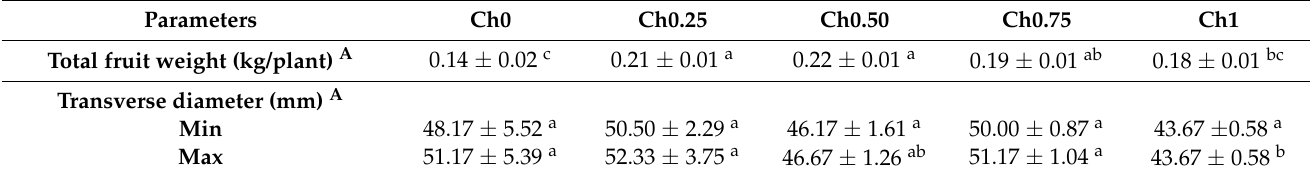
Table 2. Impact of foliar spray with chitosan on yield, fruit size, water content, Brix index, and